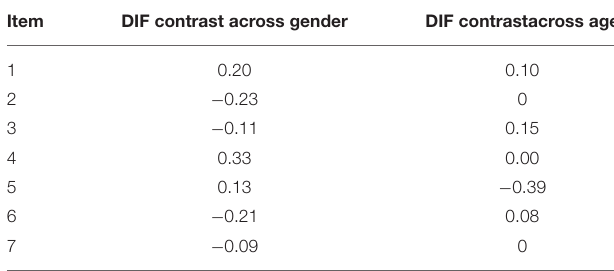
TABLE 4 | Differential item functioning (DIF) for gender and